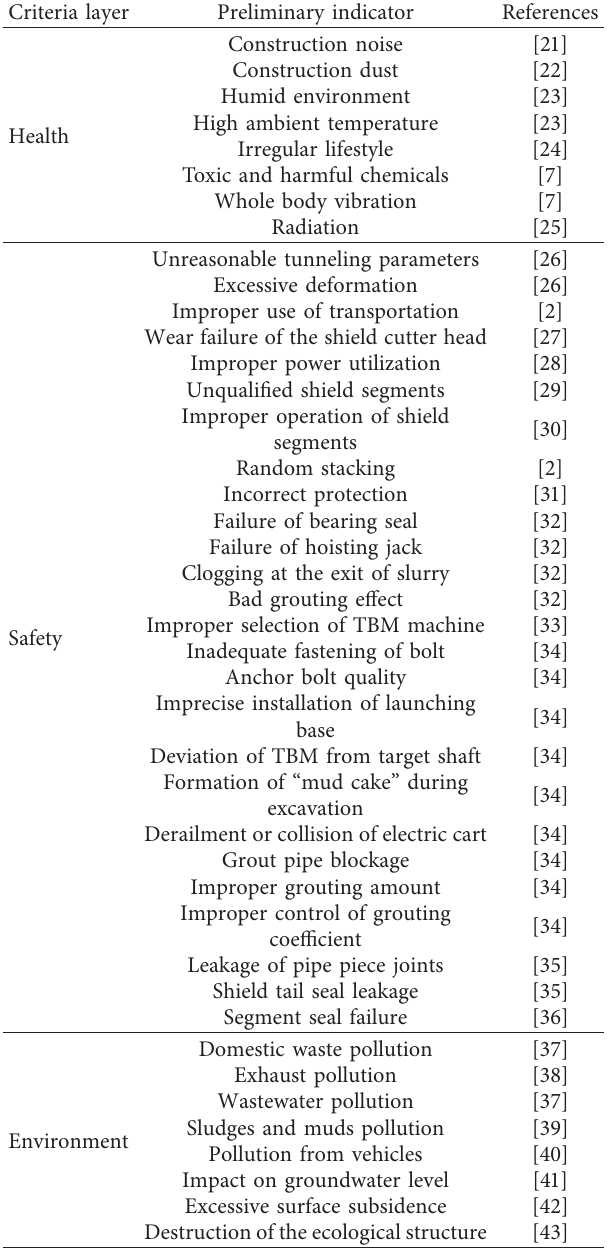
Table 1: Identification results of HSE risk